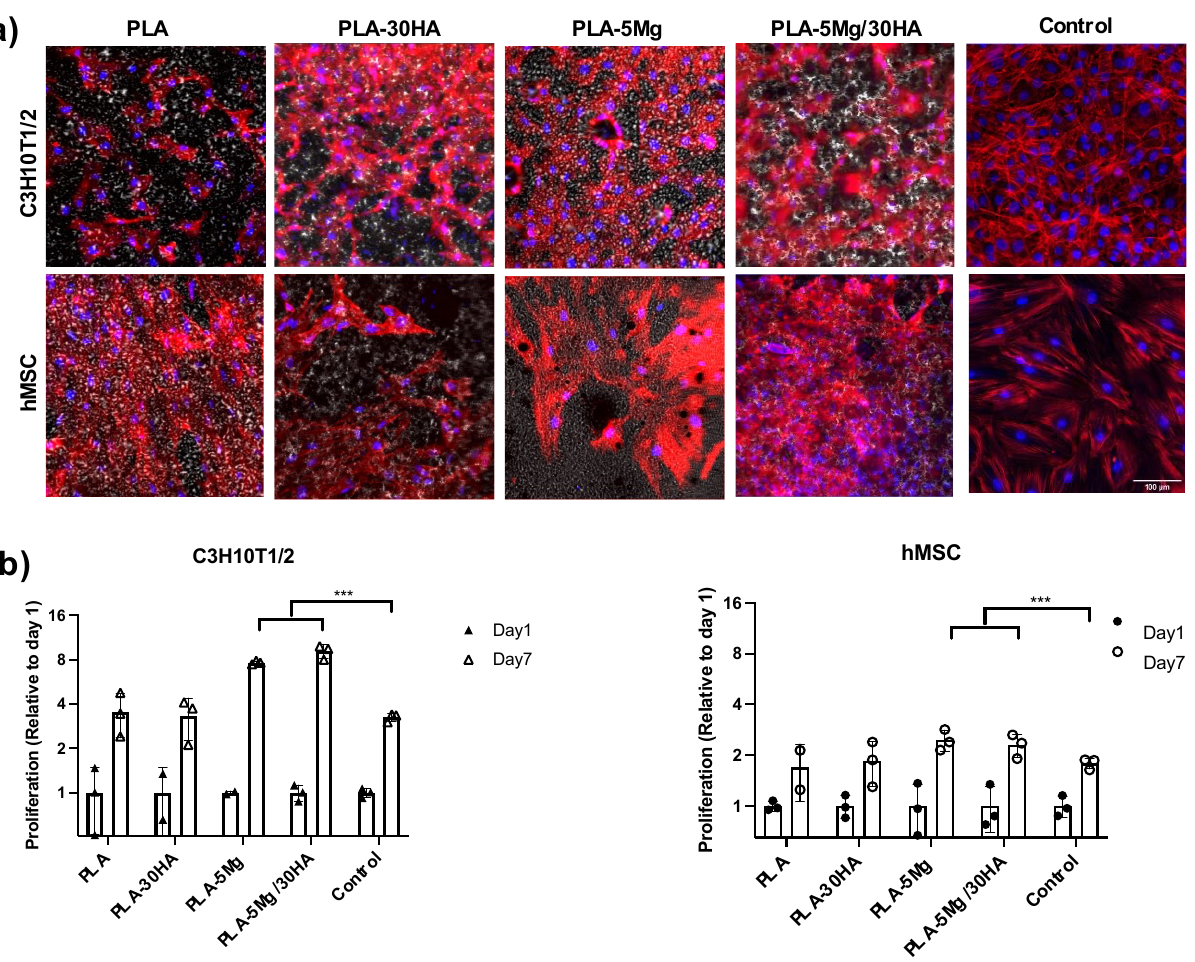
Figure 7. Cell proliferation 7 days after cell-seeding. ( a ) Confocal images of cells on the different surfaces after staining for Actin cytoskeleton (Red) and DAPI nuclear staining (Blue) (scale 100 µm). ( b ) Alamar blue cell metabolism assay data normalized to data obtained at 24 h to represent the increase associated with cell proliferation on each specific surface ( n = 3 replica per surface).